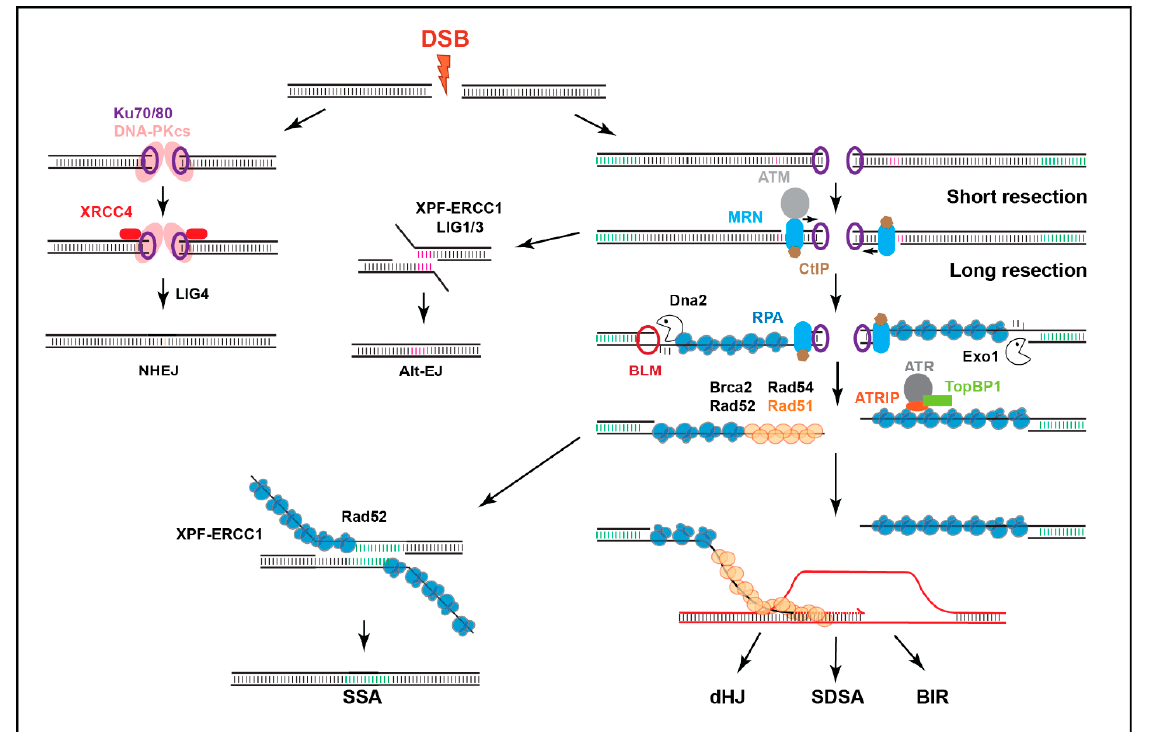
Figure 2. Main DSB repair mechanisms. DSBs are mainly repaired by HR (mostly in S/G2) or NHEJ. NHEJ involves no or minimal processing of the DSB. HR relies on DSB resection to form ssDNA that ‘invades’ homologous sequences on the sister chromatid or homologous chromosomes to enable DNA synthesis and repair. In mitotic cells, synthesis-dependent strand annealing (SDSA) is the most common HR pathway, although break-induced replication (BIR) also frequently occurs near telomeres. Double-Holliday junction (dHJ) repair is better characterized in meiosis. Extensively resected DSBs can also utilize the Rad51-independent pathway of single strand annealing (SSA) when repeated sequences are available, while alternative-end joining pathways (Alt-EJ), such as MMEJ, involve limited resection to expose micro-homologies.